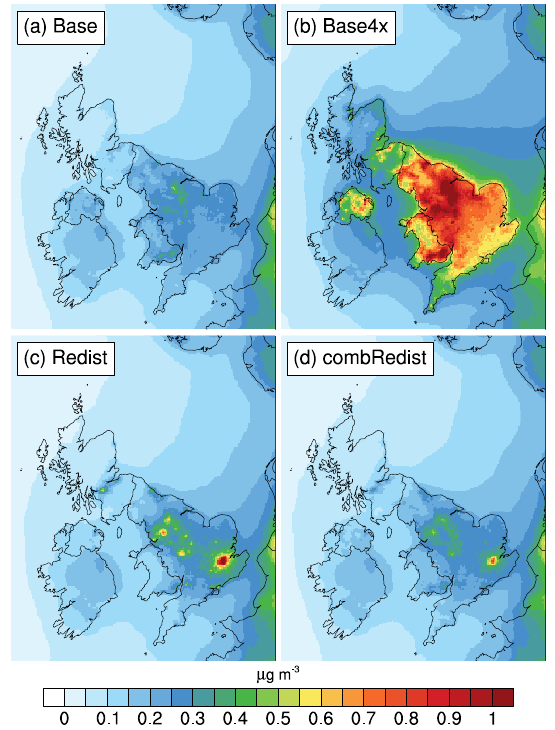
Figure 3. Annual average modelled surface SFOA concentrations for the year 2012 using the emission scenarios shown in Fig. 2: (a) Base : as in the NAEI, (b) Base4x : Base increased by a fac- tor of four over the whole of UK, (c) Redist : UK emissions re- distributed by residential population density (national total same as Base ), (d) combRedist : half of the total emission redistributed by residential population density, half as reported by NAEI (a combi- nation of a and c ). The national total is the same for (a, c, b)